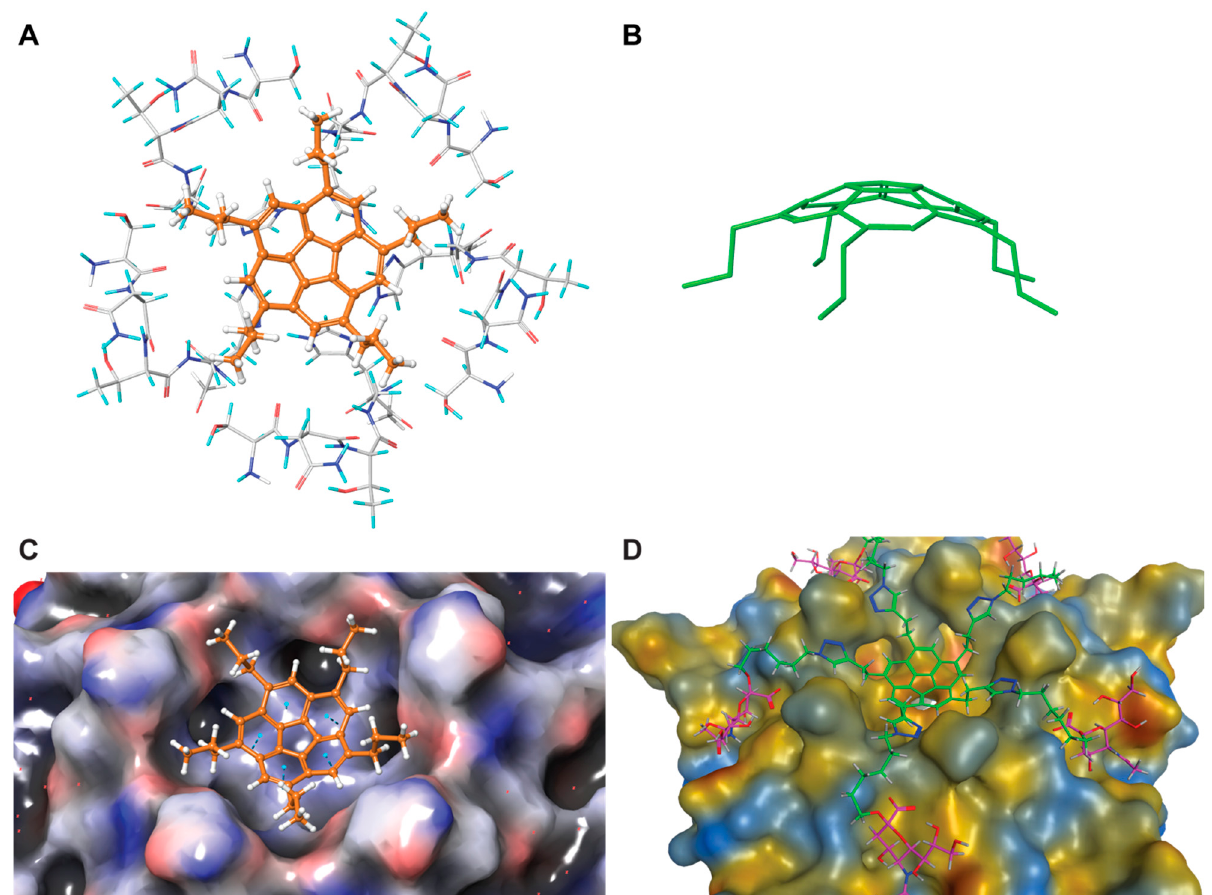
Figure 1. Energy minimization and modelling of scaffold and a pentavalent Neu5Ac conjugates to CVA24v. ( A ) penta-propyl-corannulene and CVA24v atoms were included in the docking. ( B ) Energy minimized structure of the penta-propyl-corannulene. ( C ) Quantum mechanical molecular modeling of penta-propyl-corannulene scaffold to a truncated part of the “lectin receptor” of CVA24v. ( D ) Molecular mechanical modeling of a scaffold replaced corannulene-based pentavalent Neu5Ac conjugate to CVA24v.